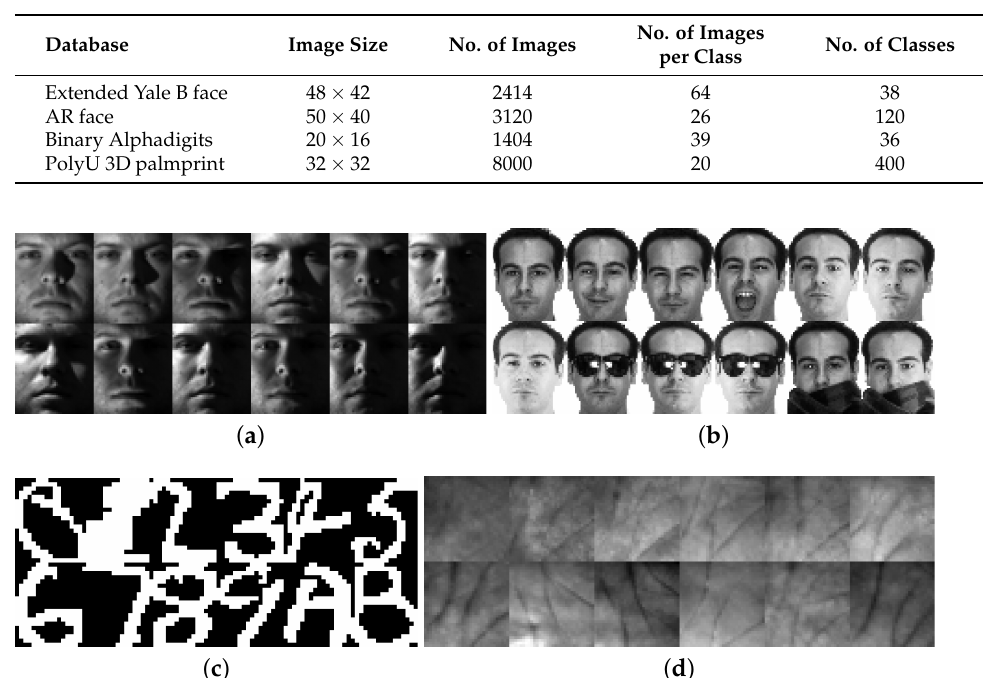
Table 2. The statistics of the four databases used in the experiments.